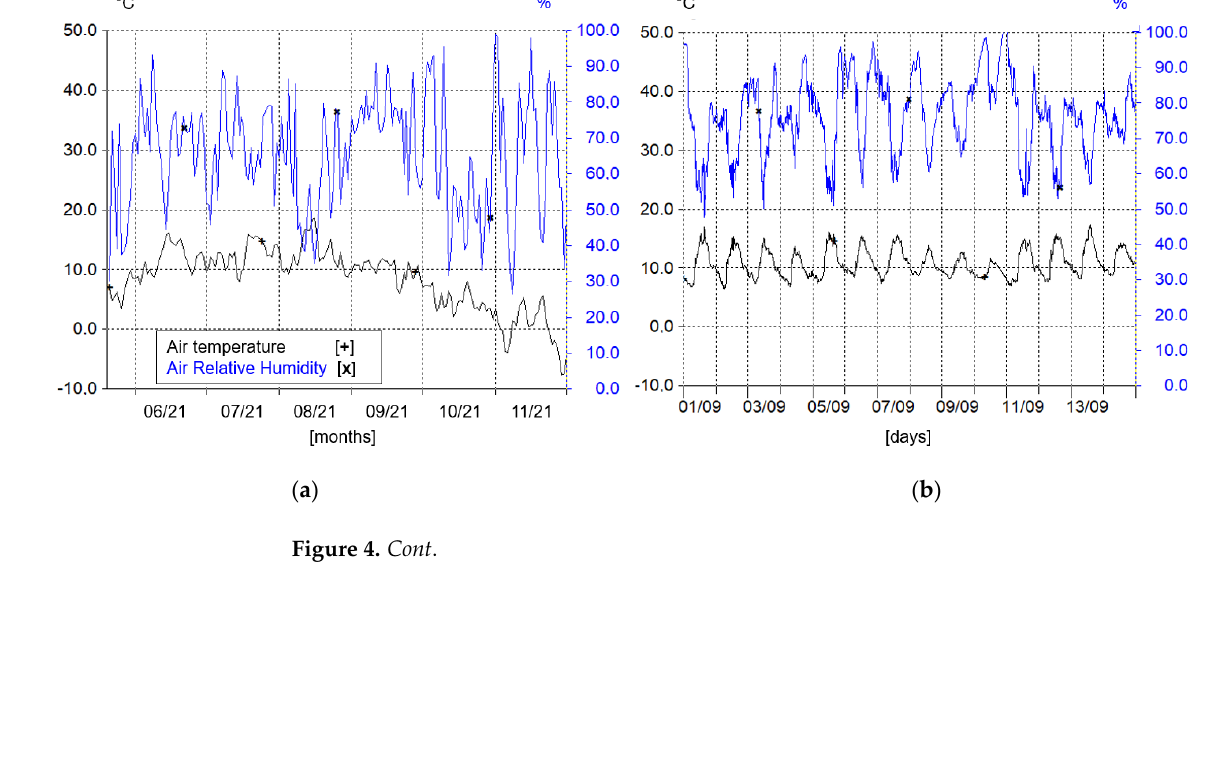
Table 3. Spring outflow sensors.